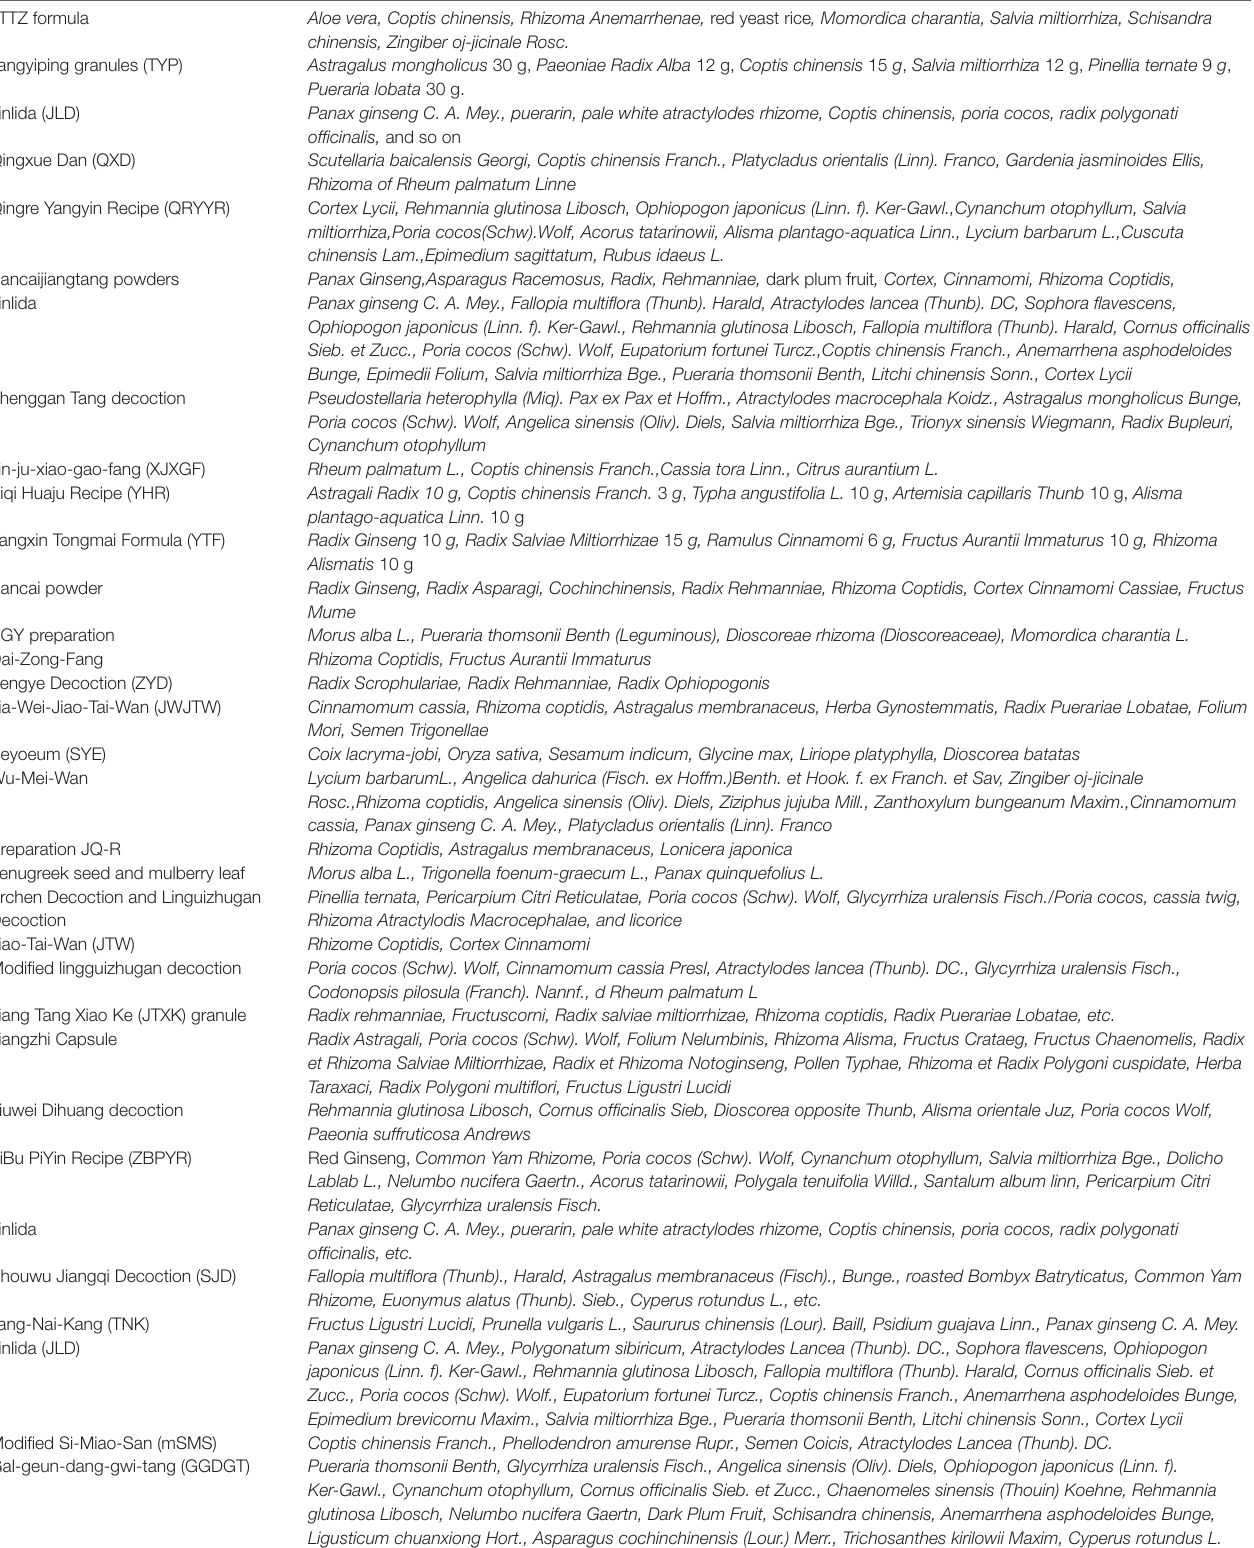
TABLE 7 | Composition of herbal formula. JTTZ